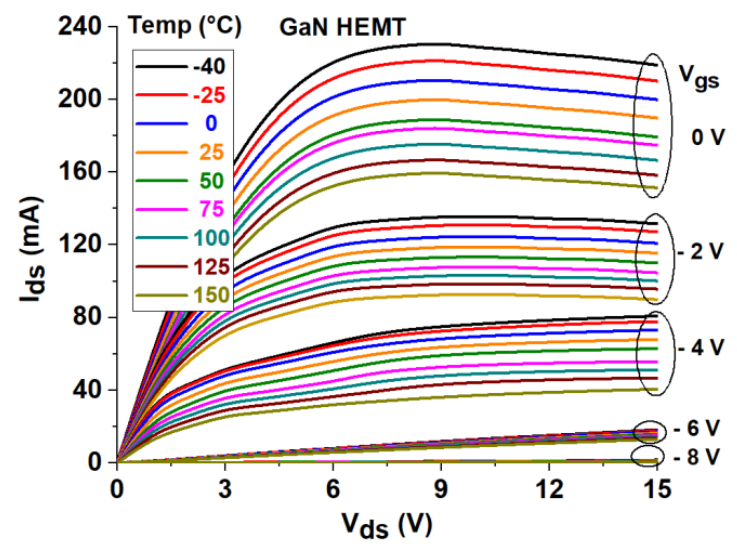
Figure 2. DC output characteristics of the studied GaAs HEMT at different T a .